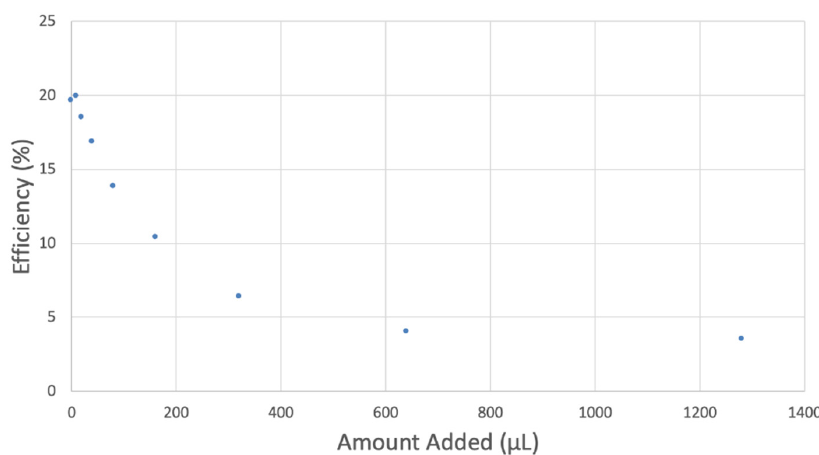
Figure 16. Black seed oil collection efficiency.